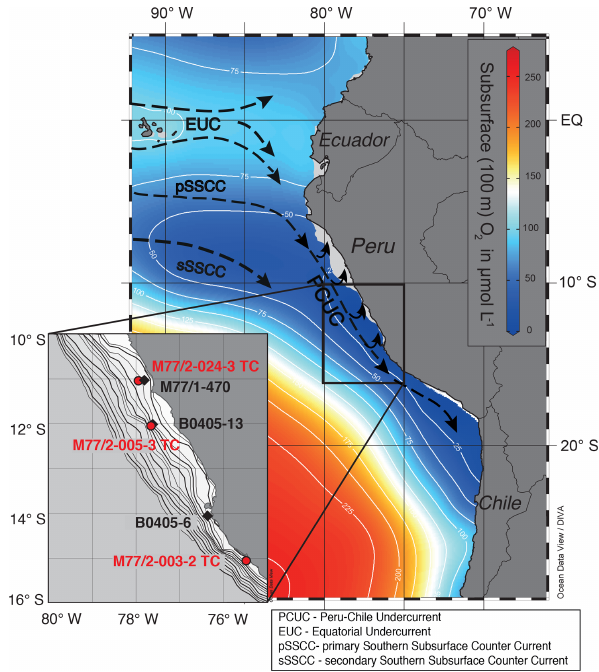
Figure 1. Subsurface (100m) oxygen concentration and current di- rections in the eastern equatorial Pacific. Inset map shows locations of cores M77/2-024-3 TC, M77/2-005-3 TC, M77/2-003-2 TC (this study), M77/1-470, B0405-13 and B0405-6 (Ehlert et al., 2015; Gutiérrez et al., 2009) in more detail. The bathymetry is given for 0 to 1000m water depth in 50m